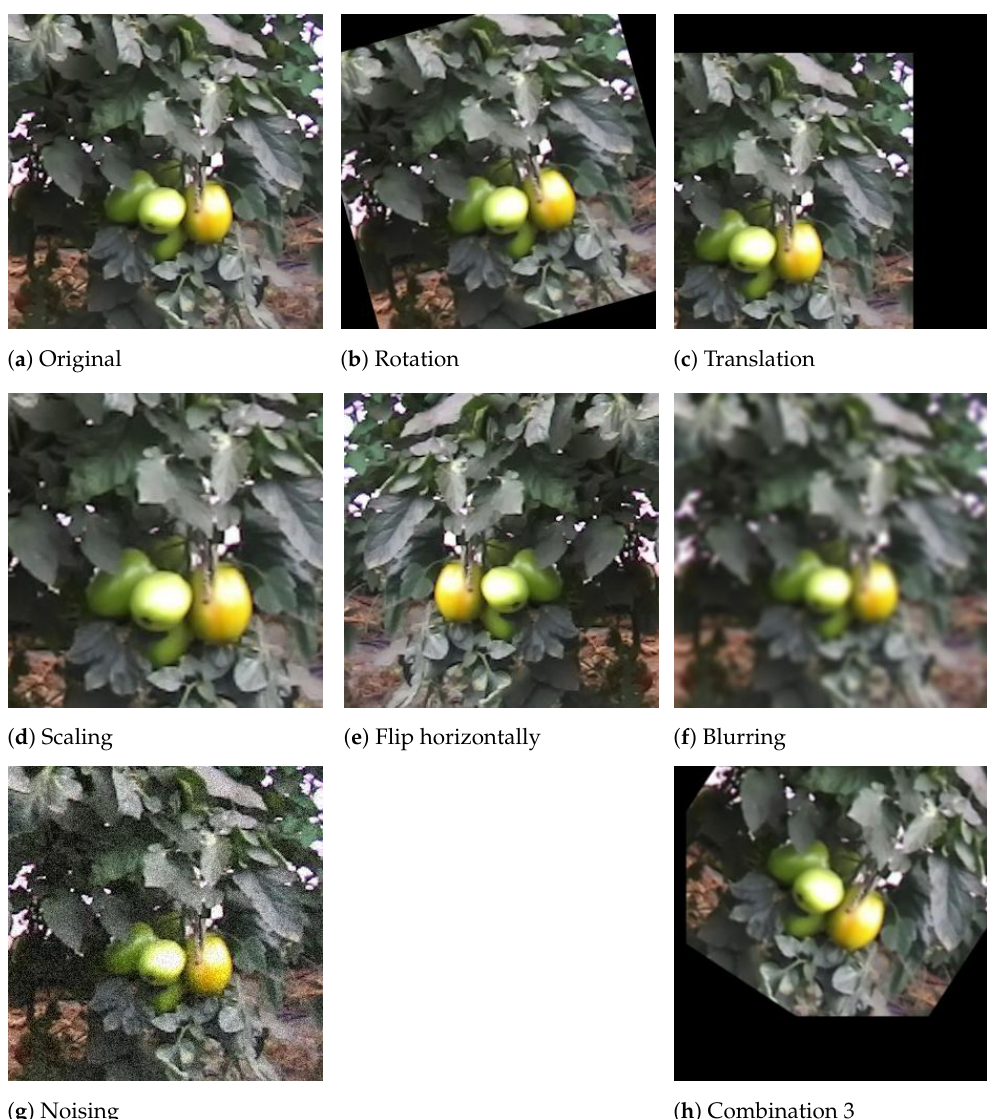
Figure 8. Example of augmentation applied to an image. ( h ) is the random combination of 3 of the other